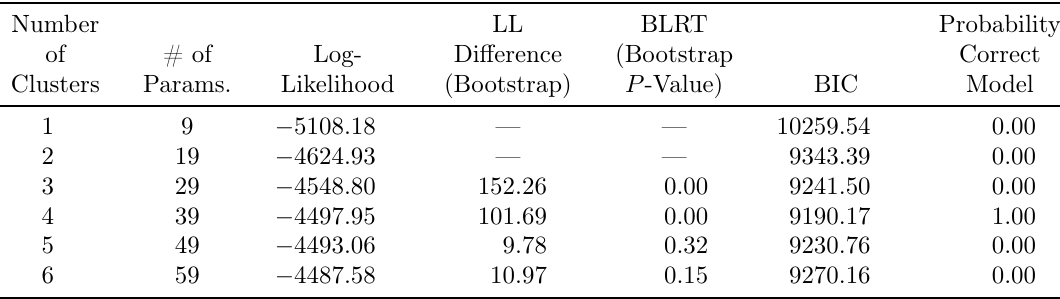
Table 3: Descriptive Statistics for Least Liked